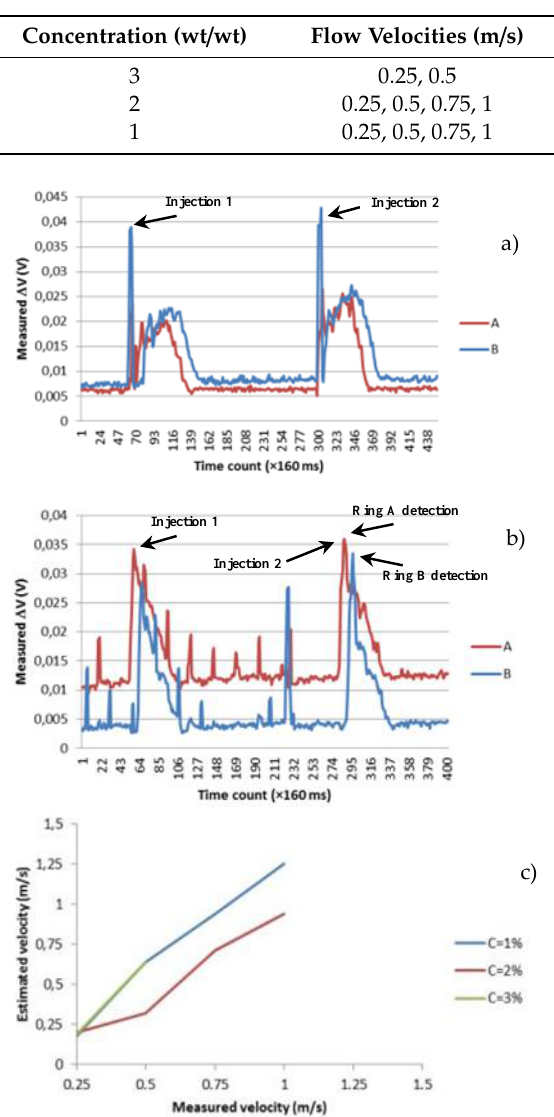
Figure 11. EIT injection test trials for fibre suspension concentrations of 1% and 2%, at the velocity of 0.25 m / s ( a , b ), and estimated velocity versus measured velocity for all fibre concentrations ( c ).